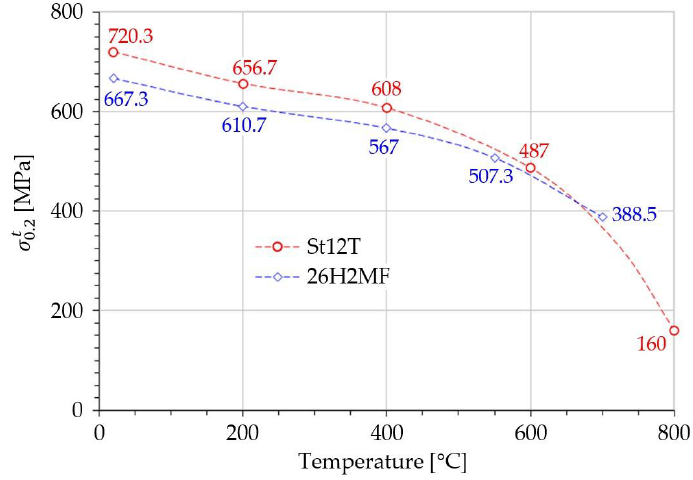
Figure 3. Tension elastic limits for two key heat-resistant steels (St12T and 26H2MF) at elevated temperatures (26H2MF curve added only for reference). Elastic region asymmetry coefficients presented in Figure 4 were calculated accord- ing to Equation (50) and the yield strength limits presented in Table 1.